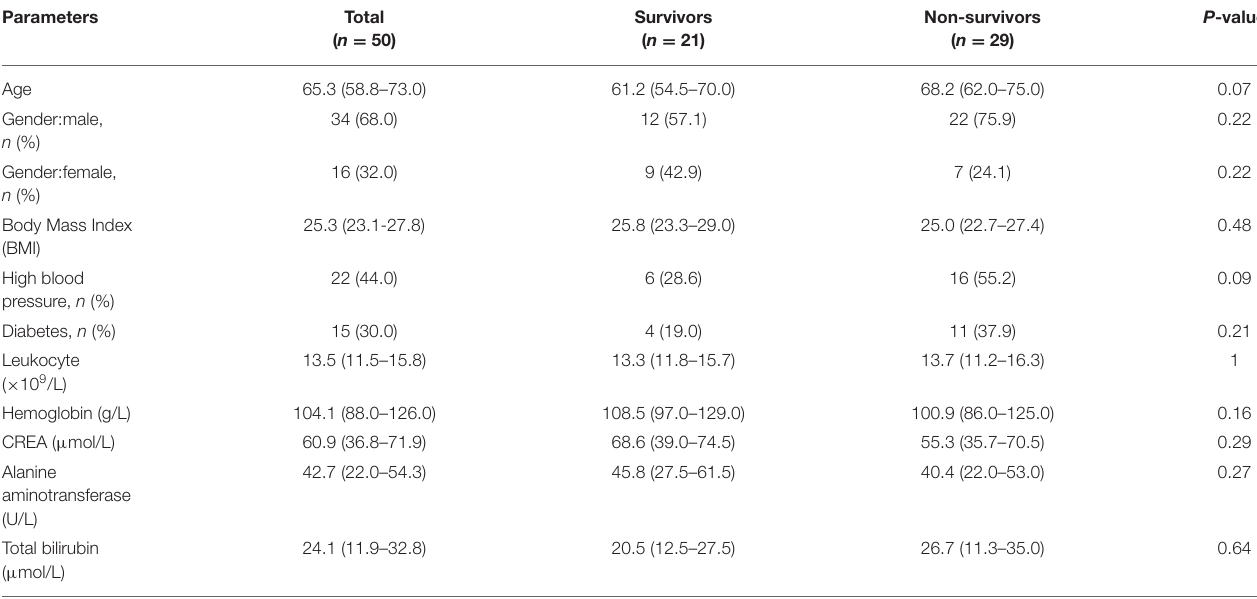
TABLE 1 | General characteristics of patients with extracorporeal membrane oxygenation.